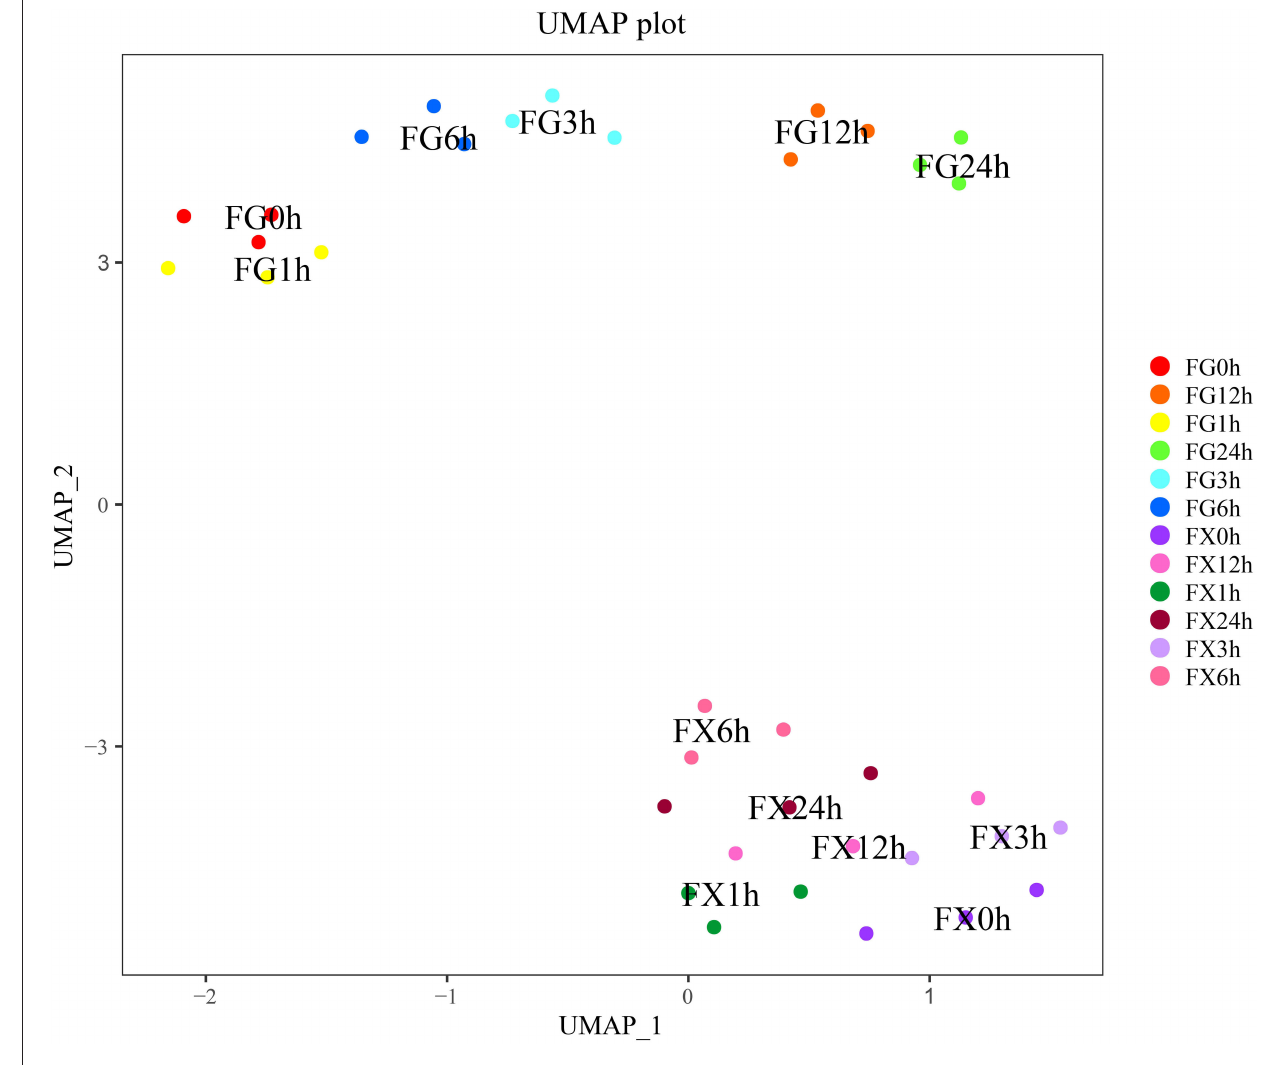
FIGURE 4 | The uniform manifold approximation and projection (UMAP) of the plant hormone components for Z. bungeanum varieties FG and